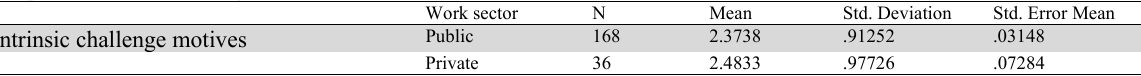
Group statistics for challenge motives